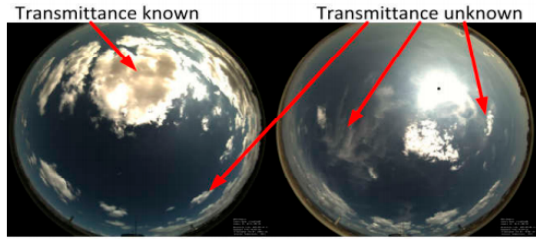
Figure 1. Sky images of a TSI [9].